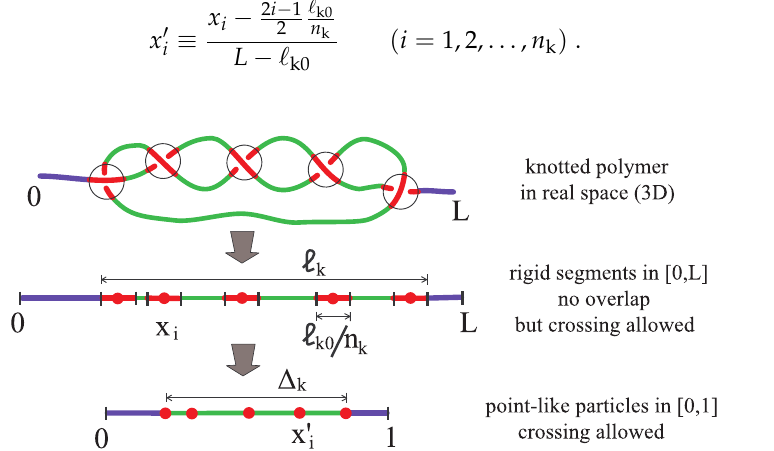
Figure 2. Modeling the unknotting dynamics. Central quantities are the topological invariants n k (number of essential crossings) and (cid:96) k0 / σ (knot minimal size). A knot of contour length (cid:96) k is first mapped onto n k rigid segments in [ 0, L ] . Then, rigid segments are mapped onto point-like particles (cid:96) k (cid:96) k0 = x (cid:48) n x (cid:48) − diffusing in [ 0,1 ] . ∆ k is the rescaled excess knot 1 (cid:96) k0 L ≡ k − −